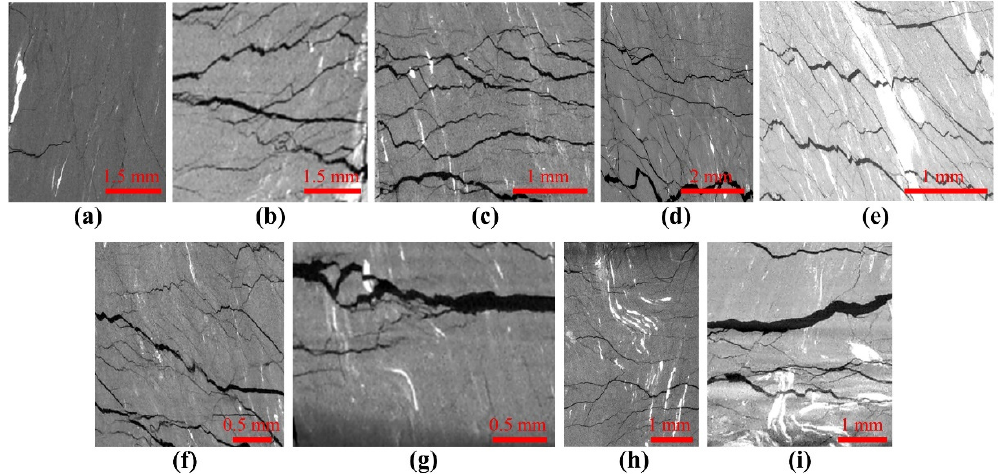
Figure 3. Deformation characteristics of the ductile deformed coals. ( a ) Sample 2, ( b ) Sample 3, ( c ) Sample 4, ( d ) Sample 5, ( e ) Sample 6, ( f ) Sample 7, ( g ) Sample 8, ( h ) Sample 9, ( i ) Sample